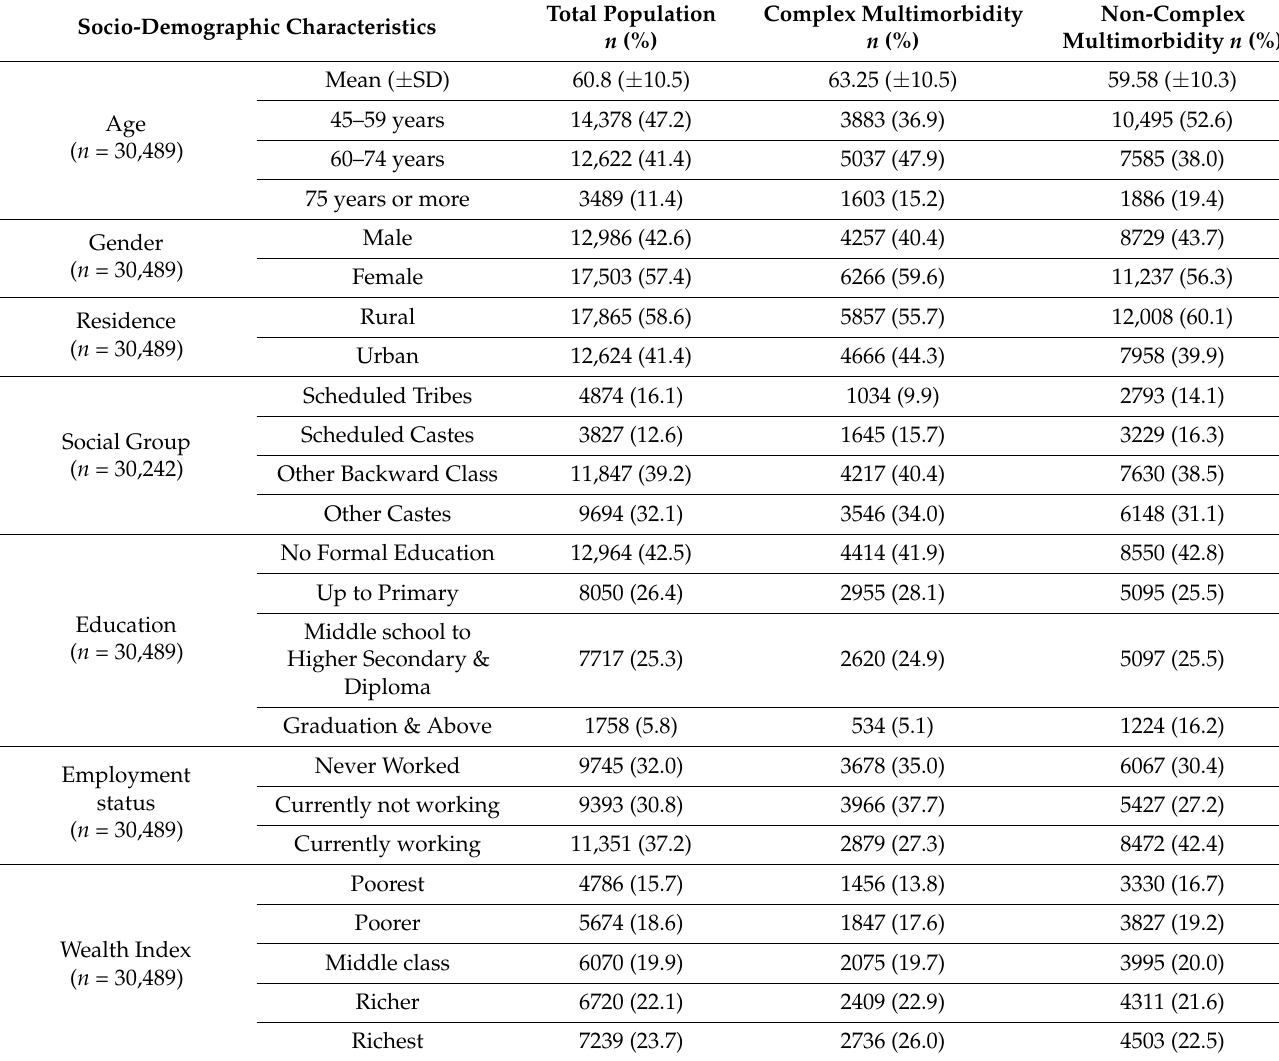
Table 2. Socio-demographic characteristics of study population (unweighted distribution).